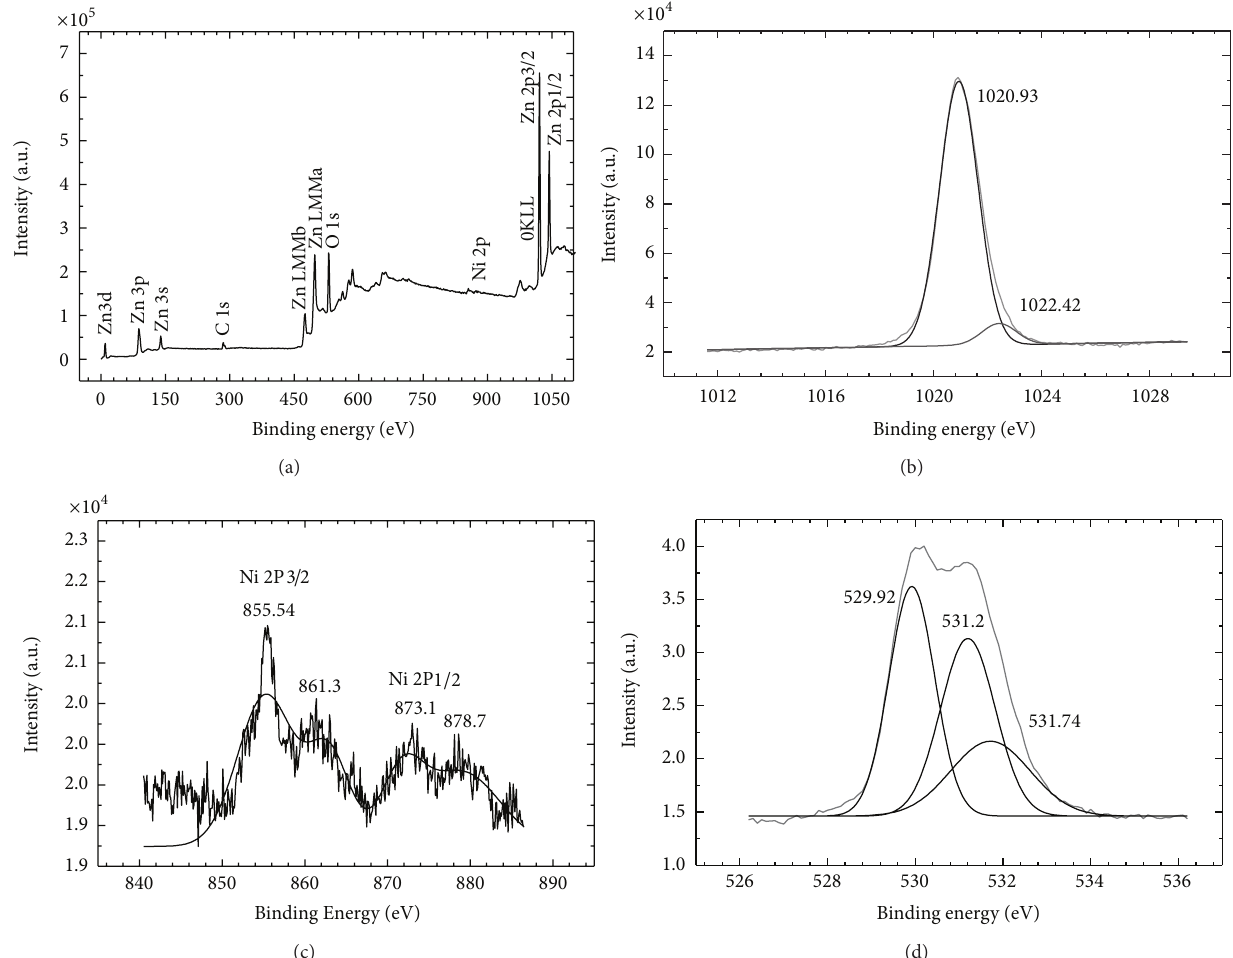
Figure 2: XPS spectra of as grown Ni doped ZnO samples: (a) Extended scan; (b) Zn2p3 spectrum; (c) Ni2p3 spectrum; (d) O1s spectrum. (The gray lines represent experimental results and the black solid curves are Gaussian fits of the